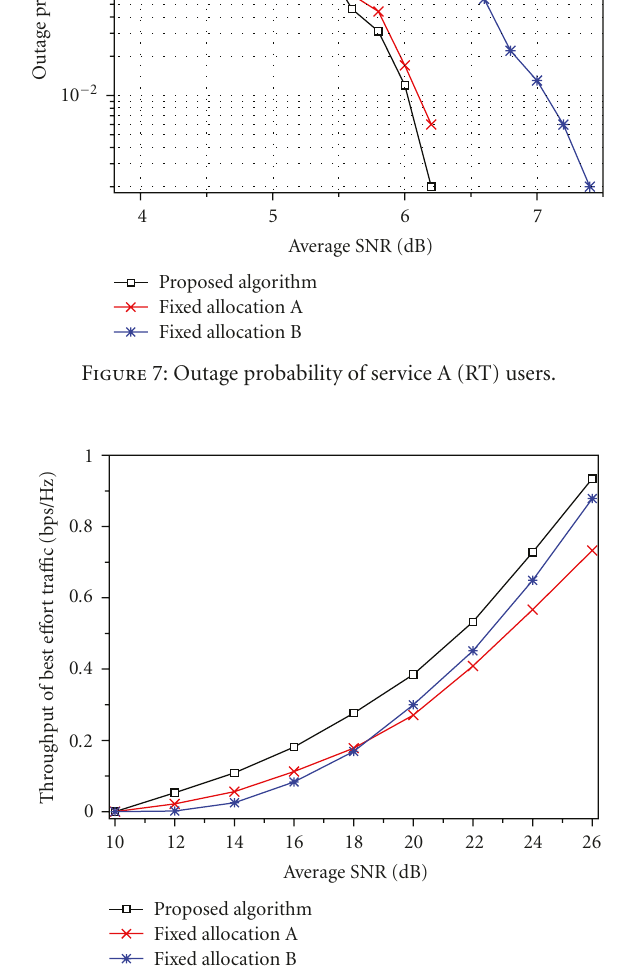
Figure 6: Outage probability of service A (the required rate is R = 0.5bps/Hz).